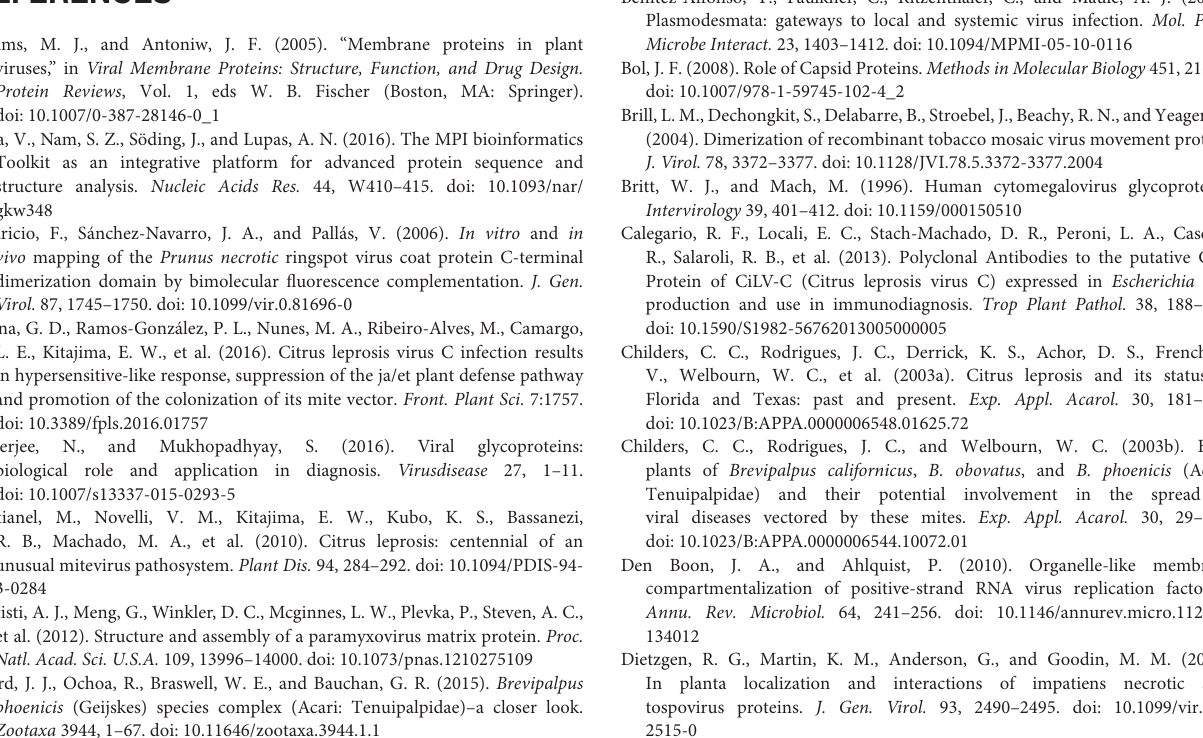
Figure S2 | Sub-localization of the proteins containing the N-terminal fused to the eGFP protein. Localization analyses of the p29, p15, p61, MP, and p24 CiLV-C proteins fused at their N-termini with eGFP (•) expressed in epidermal cell of N. benthamiana . (a) Image of expression of the •-p29 resulting in punctate (white arrow) and inclusion (red arrow) bodies dispersed within the cytoplasm. (b) Image of expression of the •-p15 with GFP signal at the nucleus (arrow) and throughout the cytoplasm. (c) •-MP expression with fluorescence signal GFP in punctate structures at the cell periphery apparently associated with PD (arrow), and pleomorphic structures in the cytoplasm (red box). (d) Image of expression of the •-p24 with fluorescence signal GFP throughout the cytoplasm, apparently associated to the ER (arrow). No spherical structures were visualized; however, filamentous structures are observed (red box). (e) Low fluorescence from •-p61 expression. The fluorescence was monitored 72 h post-infiltration (except for p61, 24–36 hpi) using a confocal Leica microscope SP8 model. Bars correspond to 50 µ m. Figure S3 | The movement protein (MP) is associated with the plasmodesmata. Expression of MP carrying the GFP (•) in N. benthamiana leaves at 72 h post infiltration. The callose deposits were stained using aniline blue ( •). The MP punctate structures co-localize at the cell periphery with the fluorochrome, suggesting accumulation of the MP at the plasmodesmata. From the left to the right, the green (GFP), blue (Aniline blue), transmitted light channels, and the merged image are shown in the figure. In a higher magnification image it is shown the co-localization of the MP with callose deposits in the plasmodesmata, and the chart of fluorescence intensities further confirms the co-localization. Distance measurement starts from the base to the tip of the arrows (x axis). The mean SD of Person Correlation Coefficient (PCC) is given in the merged image. The dotted line in the transmitted light image indicates the cell wall (CW). Red and blue bars correspond to 10 and 5 µ m, respectively.